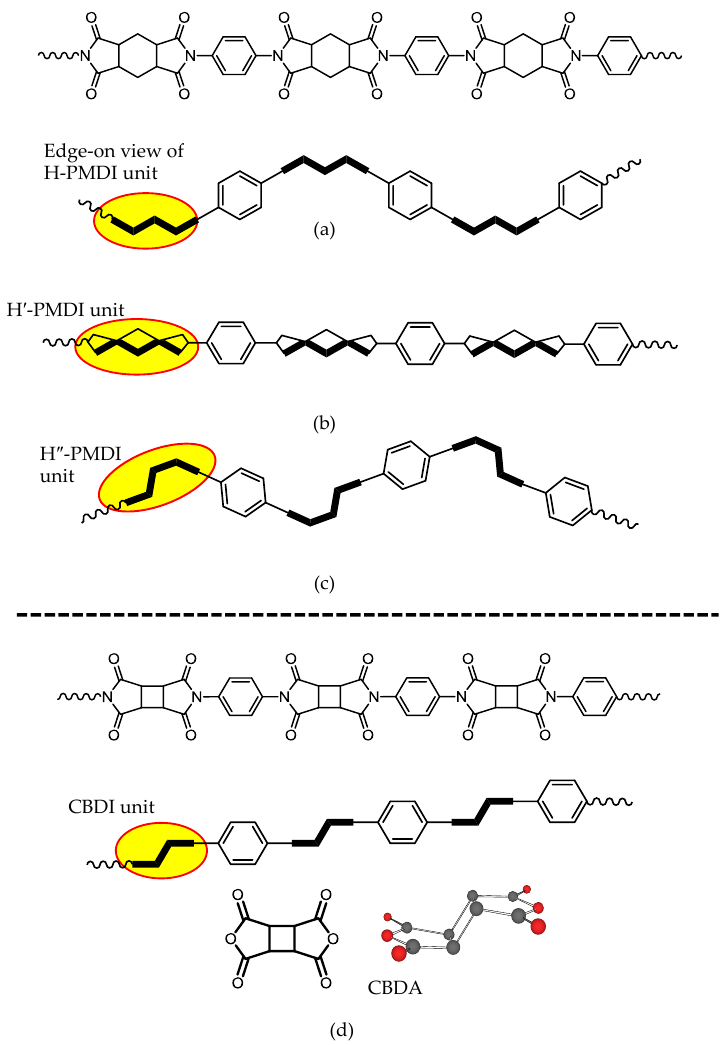
Figure 14. Schematic illustrations of extended PI chains and an edge-on view of the diimide units for the systems derived from H-PMDA isomers: ( a ) H-PMDA, ( b ) H′-PMDA, and ( c ) H″-PMDA, and ( d ) CBDA as a comparative system. The systems using p -phenylenediamine as a typical rigid diamine are shown here for simplicity. Reproduced with permission from Elsevier [37].